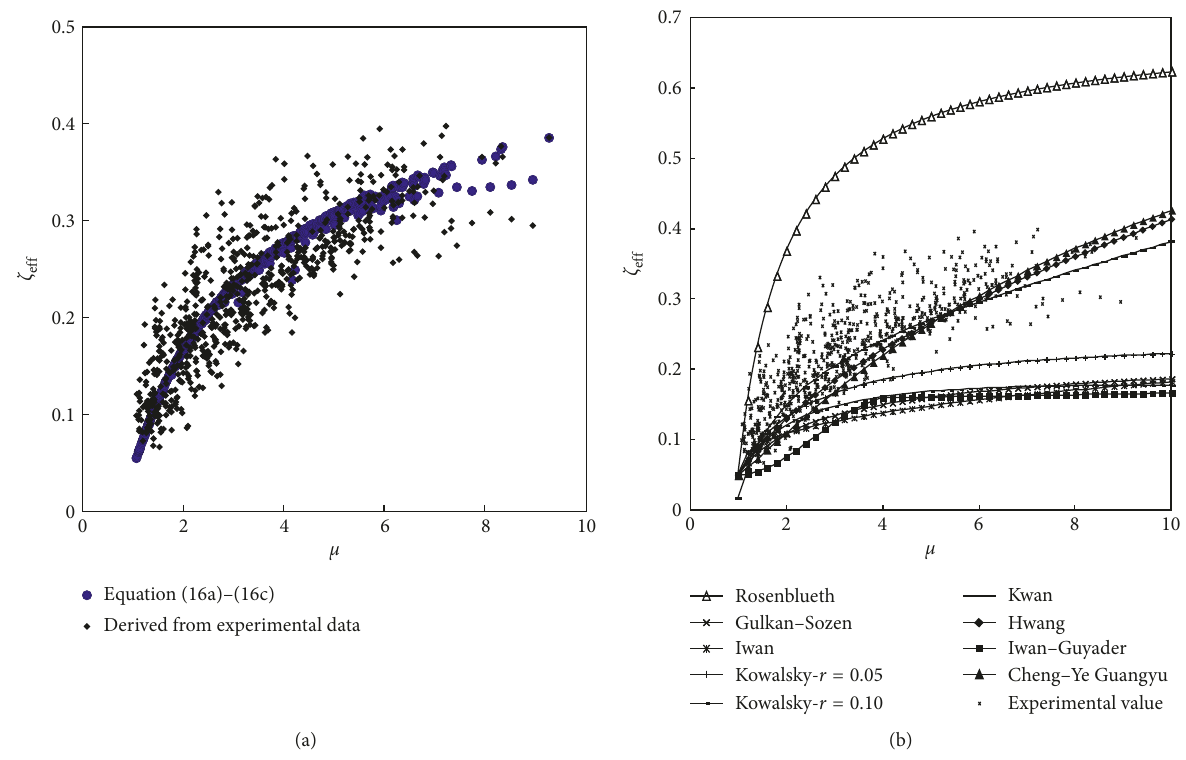
Figure 7: EVD ratio versus ductility factor: (a) predicted by (16a)–(16c); (b) predicted by the other equations. Table 2: Statistical results of the EVD ratio predicted by various models to those derived from experimental data. Model Equation of equivalent damping ratio Mean